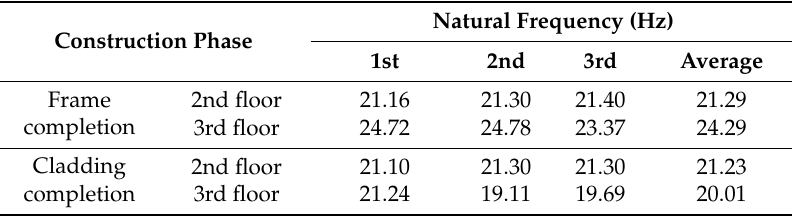
Table 6. Natural frequency of the floors for di ff erent construction phases.